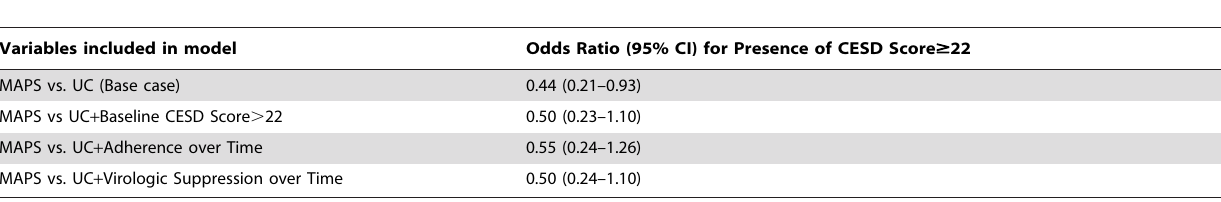
Table 3. Assessment of Potential Confounding or Mediation of the Relation between MAPS and CES-D Score $ 22 Over Time.